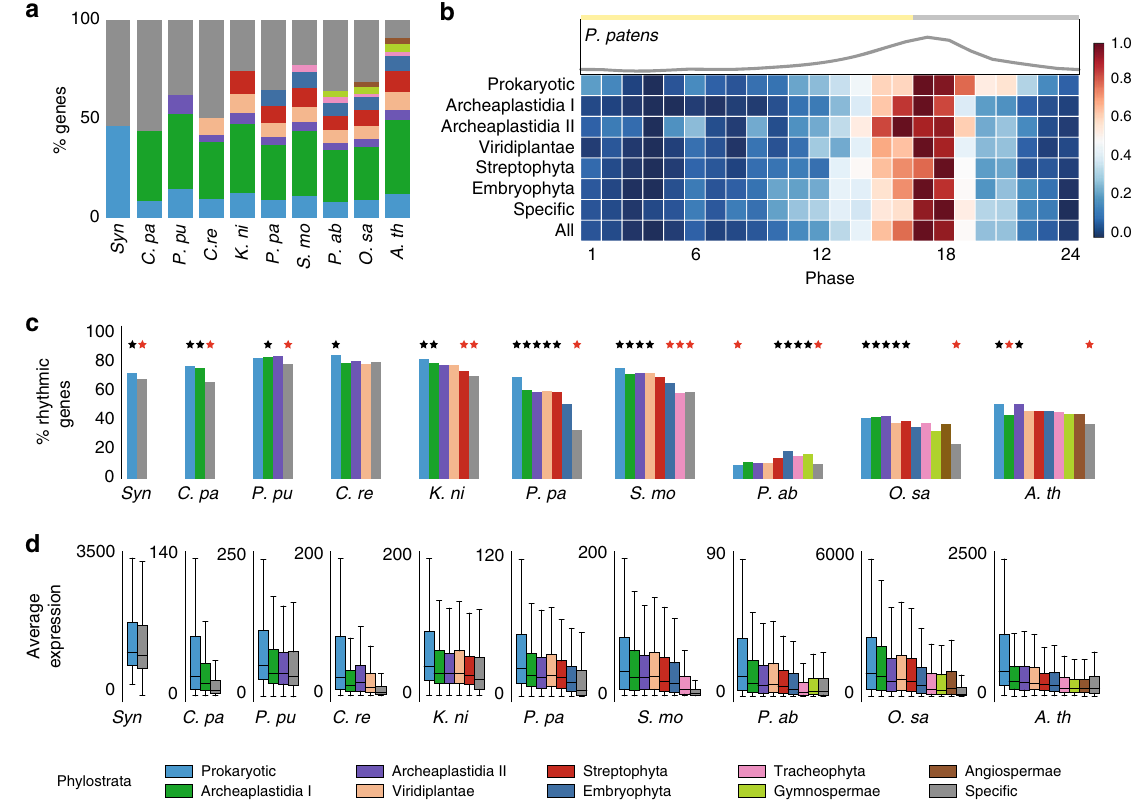
Fig. 2 Expression analysis of phylostrata. a Percentages of genes in each phylostrata per species. b Phase distribution for the phylostrata in P . patens . The plot above the heatmap shows the cumulative distribution of the phases. c Analysis of phylostrata rhythmicity per species. The bars represent the percentage of rhythmic genes for each phylostratum. Black and red stars indicate phylostrata that are signi fi cantly enriched or depleted for rhythmic genes, respectively (FDR corrected empirical p value < 0.05). d Average expression of genes assigned to the phylostrata in the different species. The center line and the bounds of the box represent the median, the fi rst and third quartile, respectively. The whiskers represent the rest of the